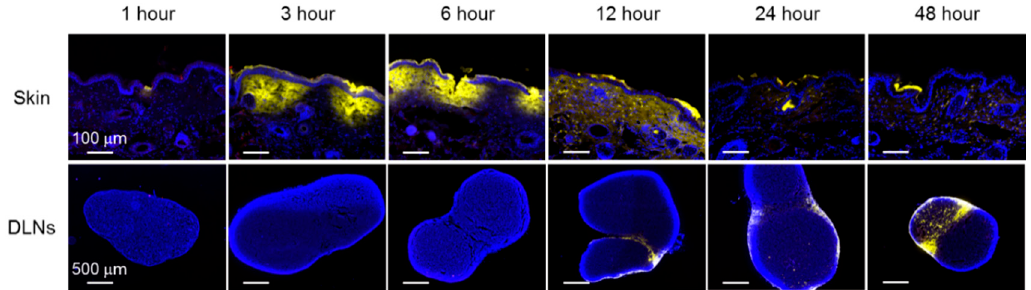
Figure 3. Localization of K3 for transcutaneous formulation. Puncture holes were made on the hairless back skin of HR-1 mice using PGA-MN. A 20 μ g/5 μ L AF647-labeled K3 solution and 10 μ g OVA was loaded on HG that was then attached to the puncture site. The treated skin and DLNs were collected and frozen in liquid nitrogen. Frozen sections were stained and observed for OVA (red), K3 (yellow) and nucleus (blue) by fluorescence microscopy.